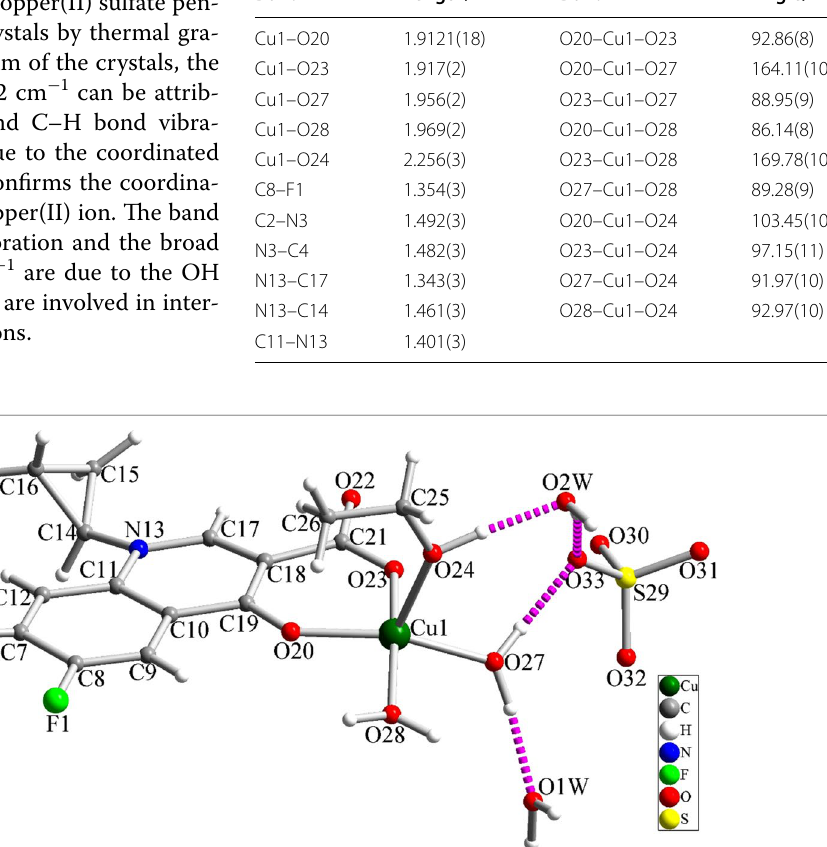
Fig. 1 The molecular structure of Cu-CIP with atom labeling. Pink dashed lines show hydrogen bond interactions